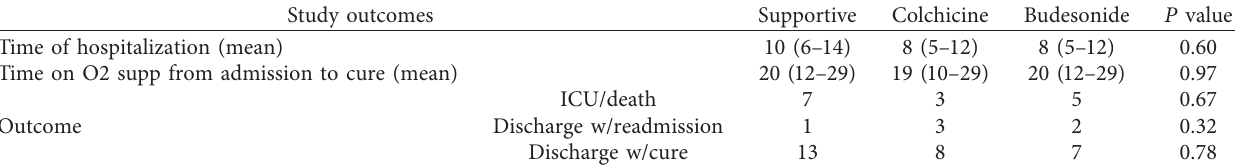
Table 4: Outcomes, hospitalization, and O2 supplementation time between admission and